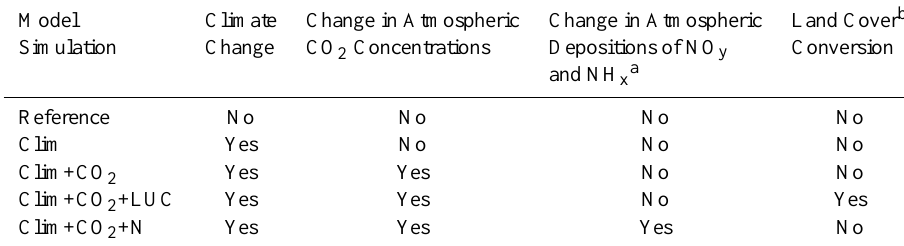
Table 2. Protocol of transient models’